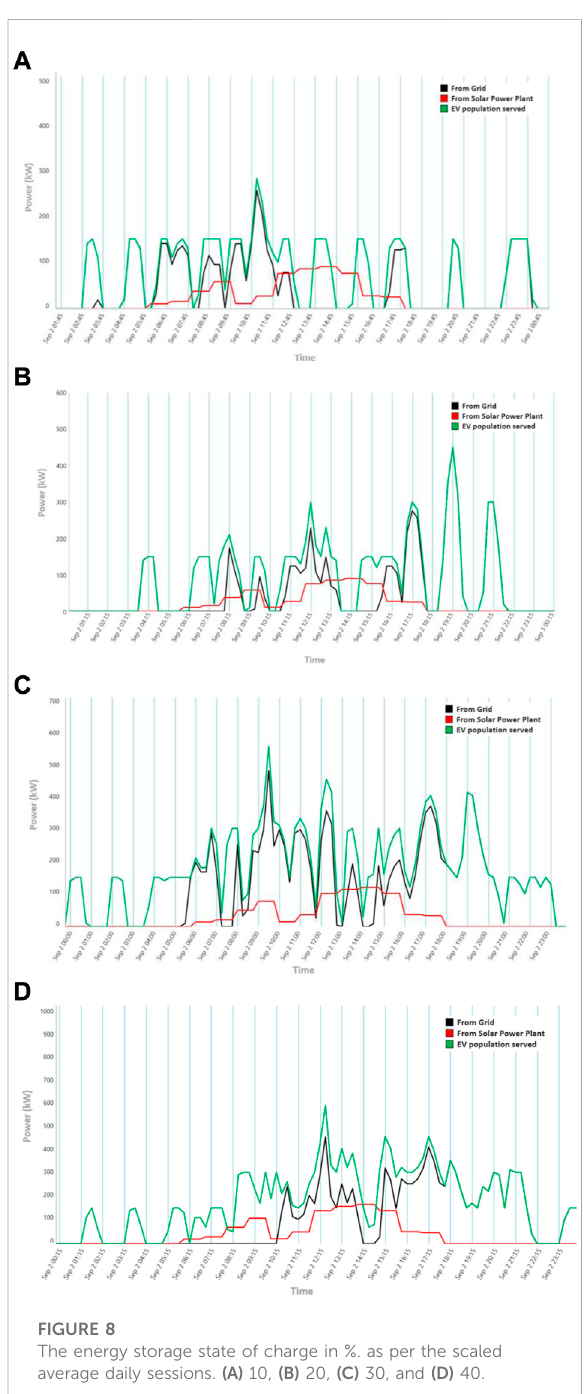
FIGURE 8 The energy storage state of charge in %. as per the scaled average daily sessions. (A) 10, (B) 20, (C) 30, and (D)